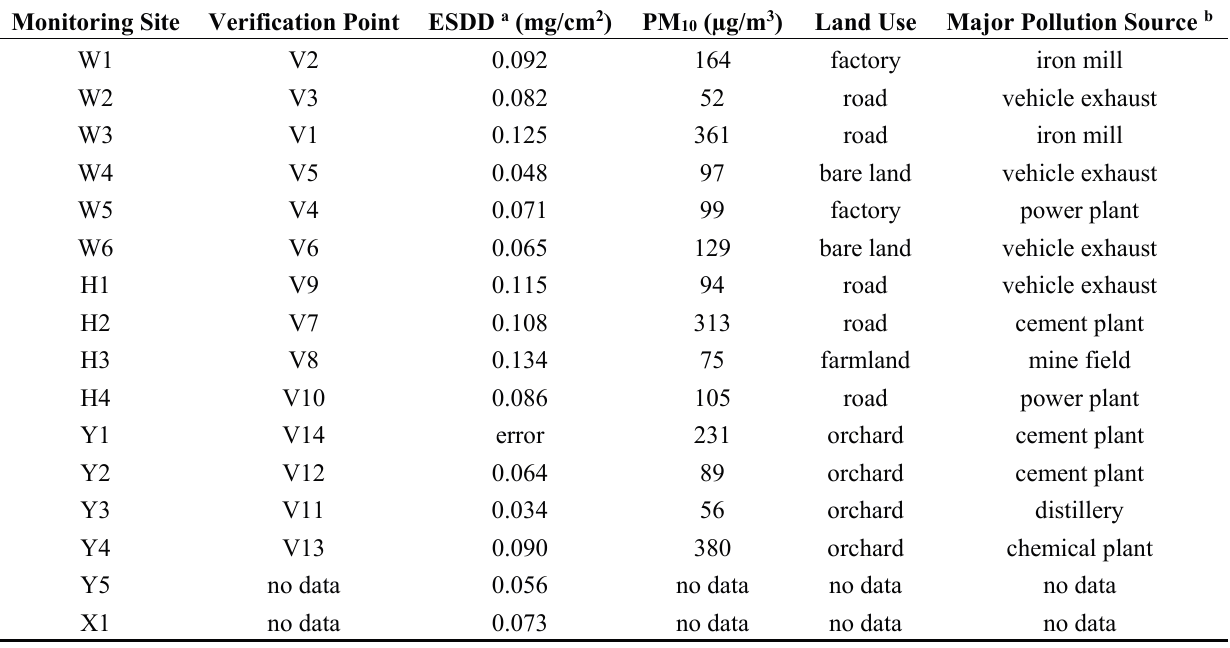
Table 1. Field investigation